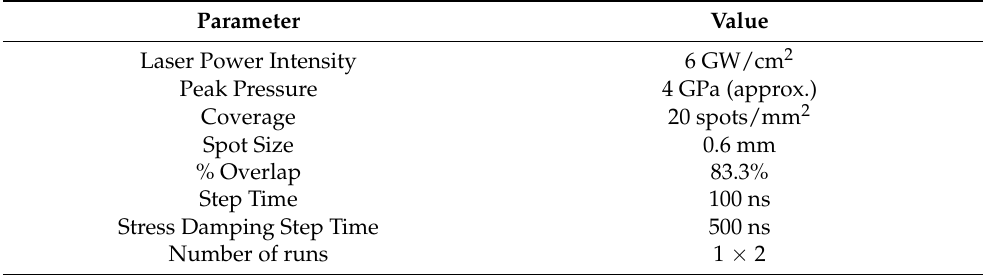
Table 1. LSP simulation parameters.